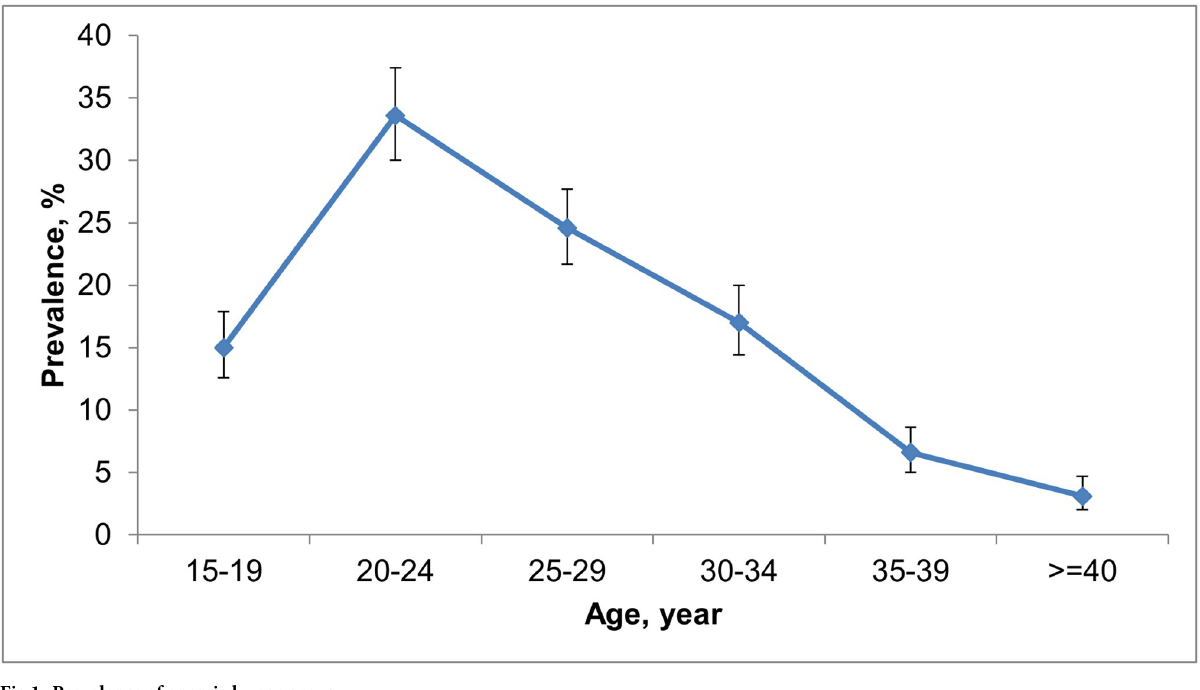
Fig 1. Prevalence of anemia by age group.